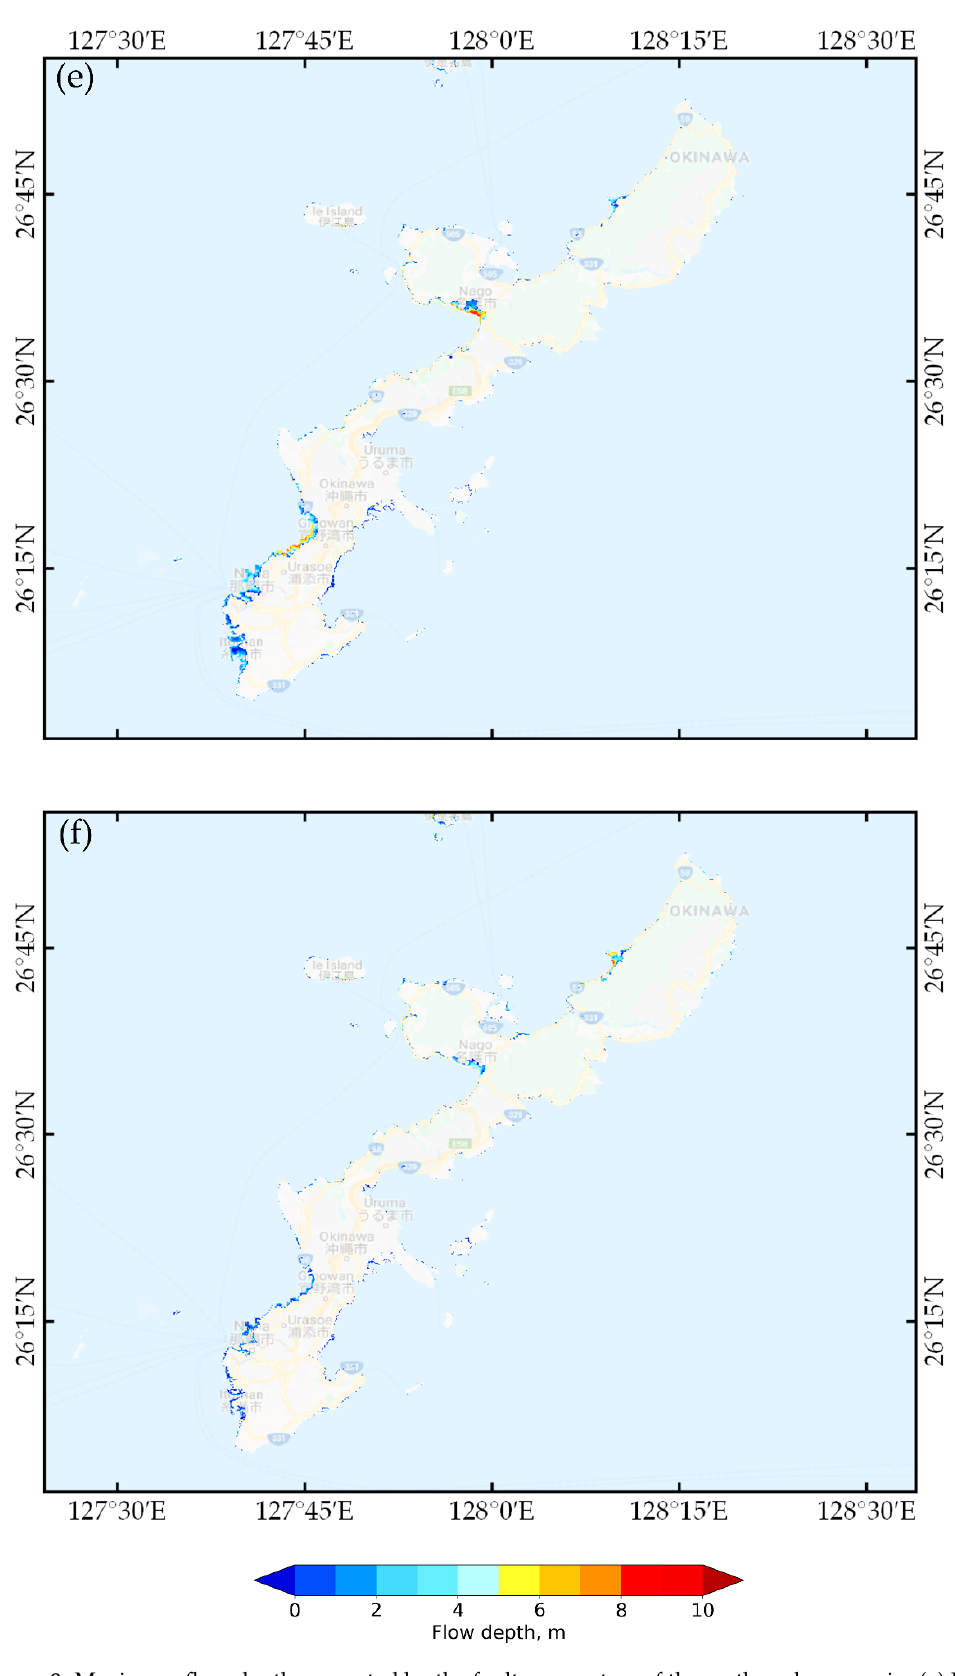
Figure 8. Maximum flow depth generated by the fault parameters of the earthquake scenario. ( a ) F1,